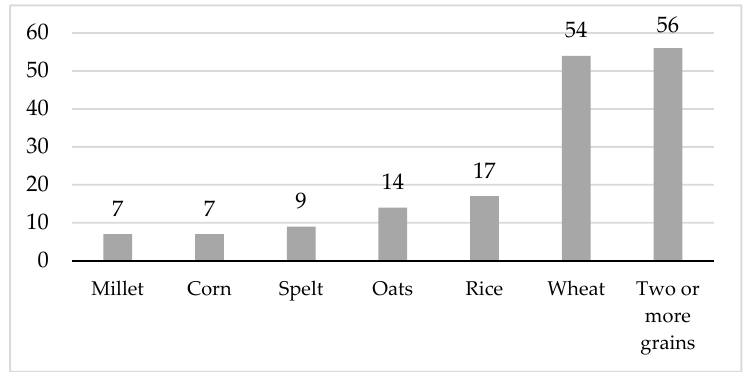
Figure 1. Number of commercial complementary cereal products by grain type.